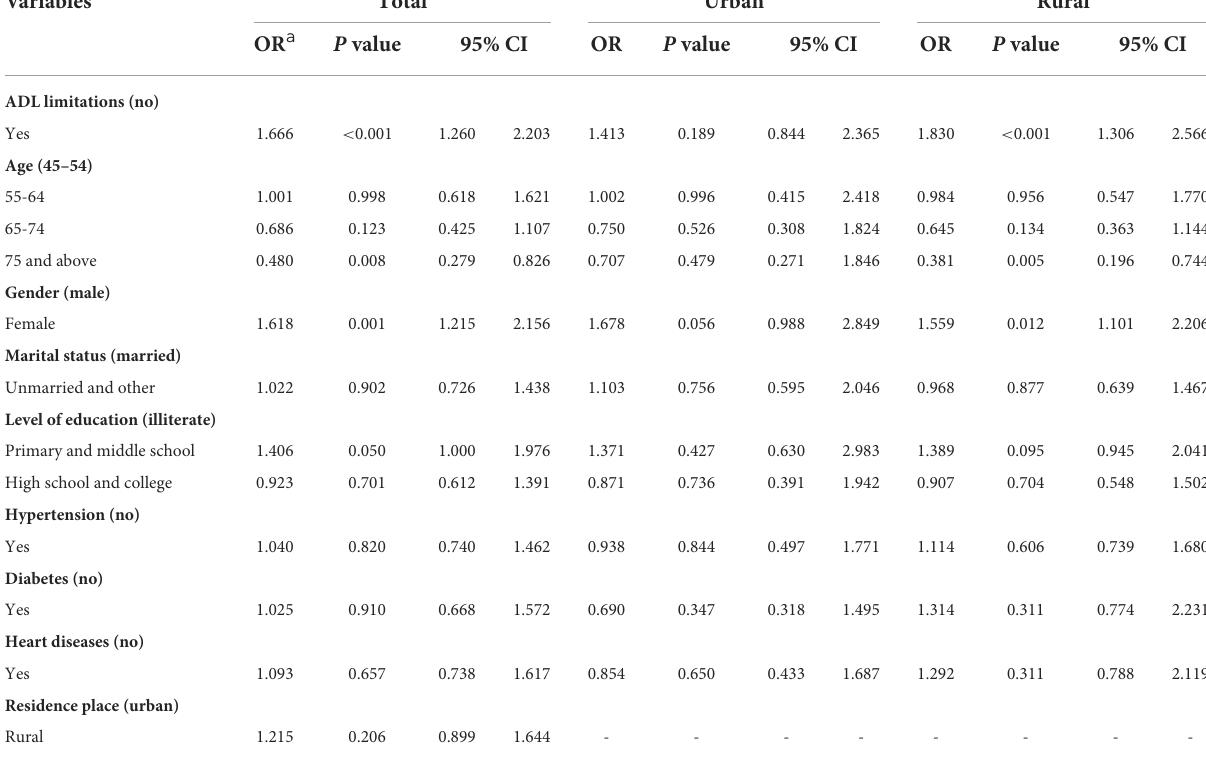
TABLE 4 Association of IADL limitations with depression among patients with